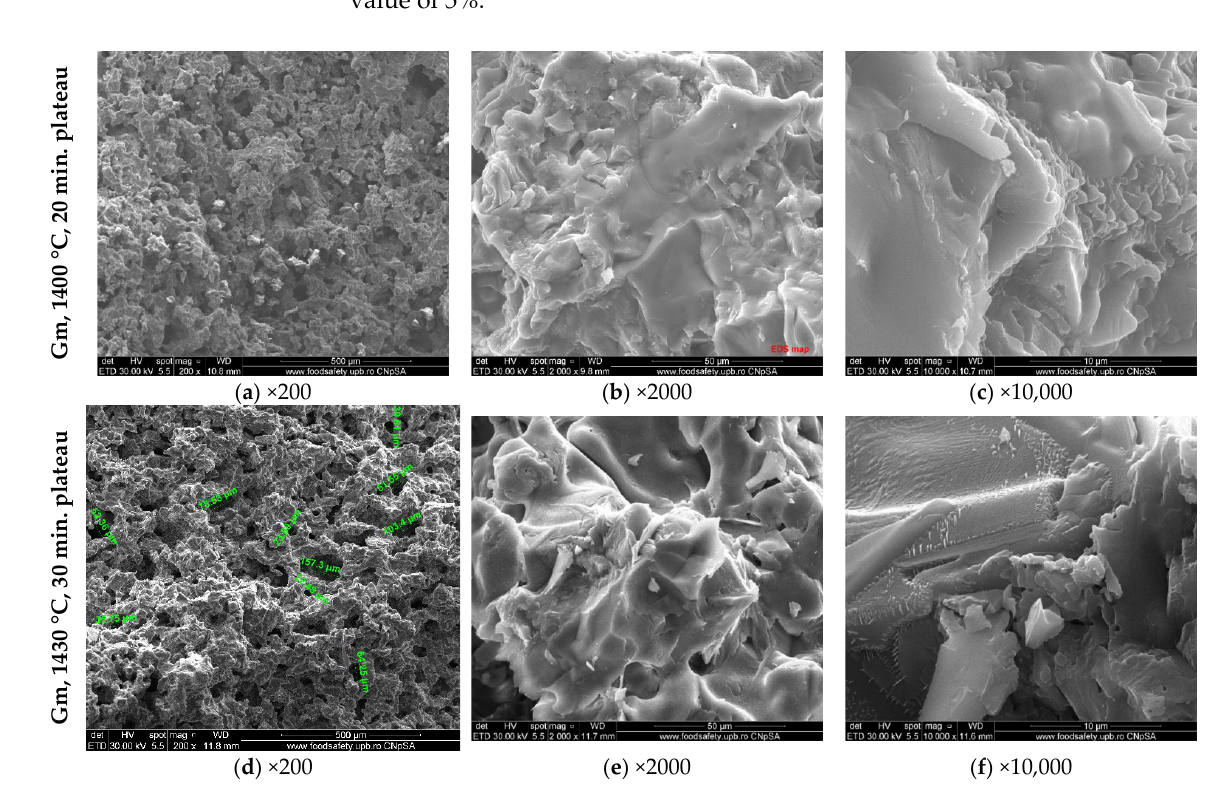
Figure 10. SEM images (different magnifications) of Gm calcined at different temperatures and plateaus (1400 ◦ C + 20 min and 1430 ◦ C + 30 min). Based on the information presented so far, the clinkers with waste glass (Gc and Gm) Table 2. Oxide compositions of were obtained by the calcination of raw mixes at 1430 °C with a 30 min plateau, and the